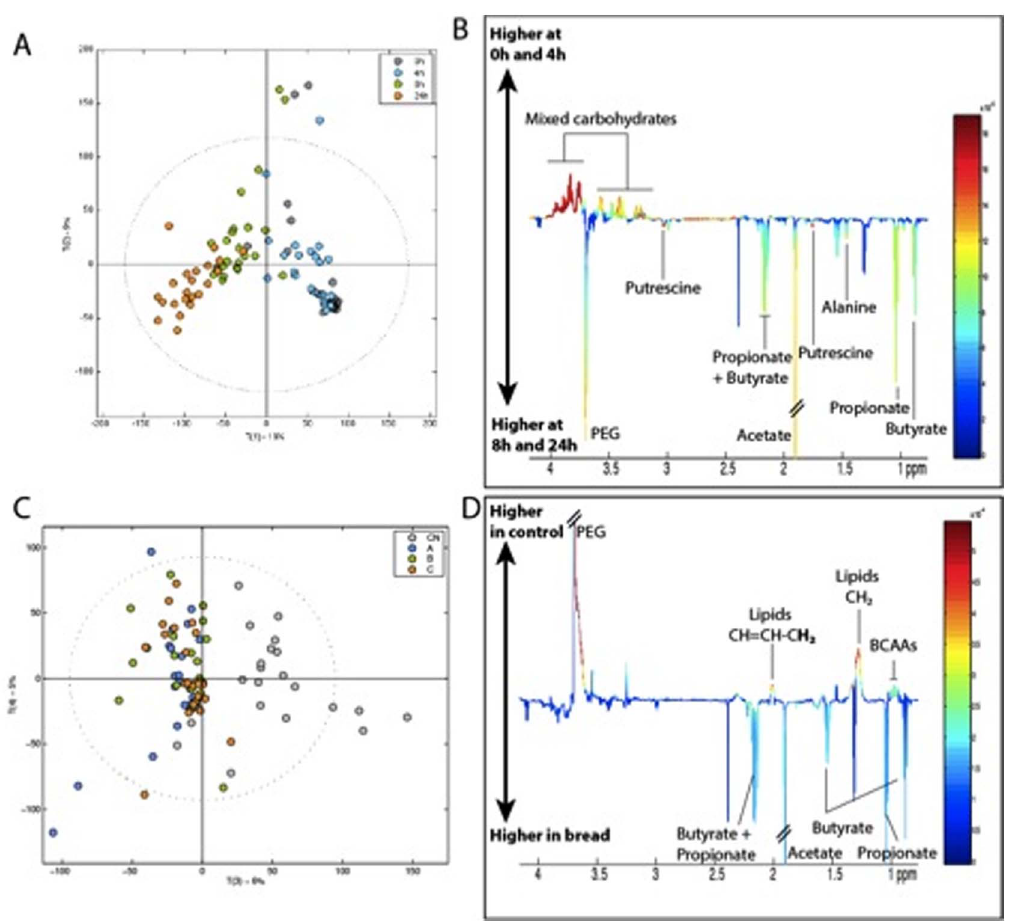
Figure 1. Metabolic trajectories of bread fermentated by gut bacteria obtained from both control and IBS patients (n=3). PC1 versus PC2 scores plot (A) and PC1 loadings (B) derived from the 700 MHz 1 H NMR spectra of fermentation supernatants color coded for collection time- points. Key: Grey: 0 h, Blue: 4 h, Green: 8 h, Orange: 24 h. PC3 versus PC4 scores plot color coded for bread (C) and PC3 loadings (D). Key: Grey: control, Blue: bread A, Green: bread B, Orange: Bread C.